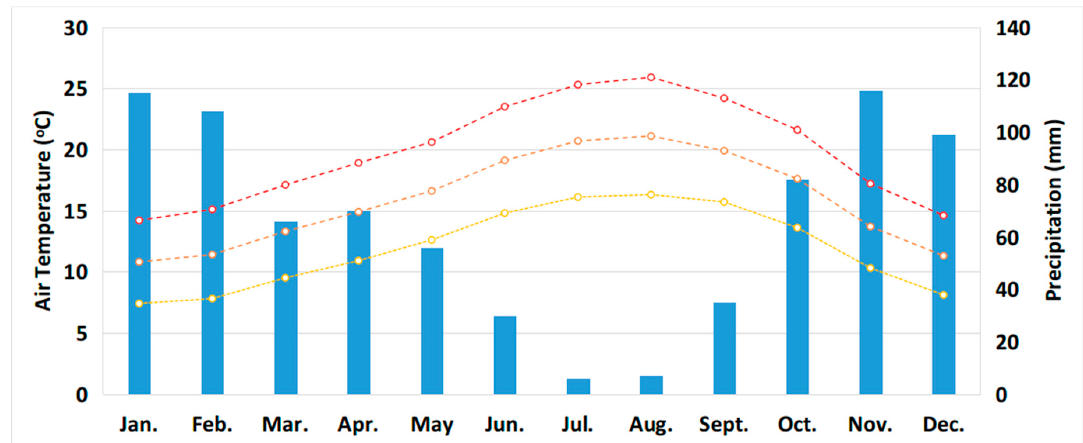
Figure 1. Location of the Lis Valley Irrigation District in Portugal ( a ), and in the center region ( b ). (source: Google Maps, https://maps.google.pt).